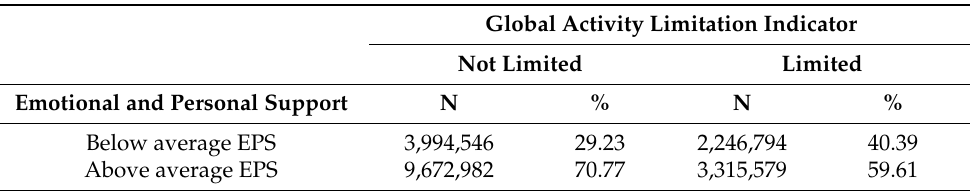
Table 4. Women by global activity limitation indicator (GALI) and emotional and personal support.